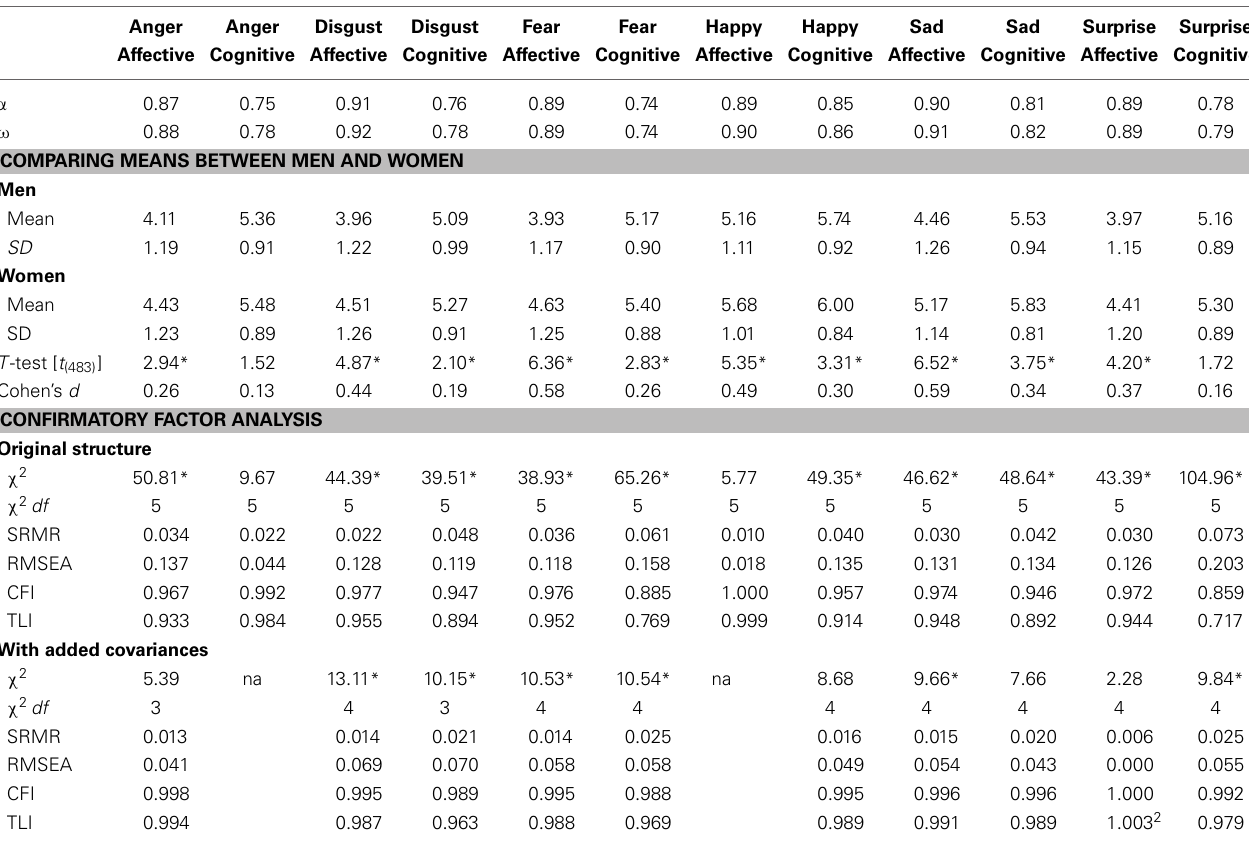
Table 1 | ESE Subscale